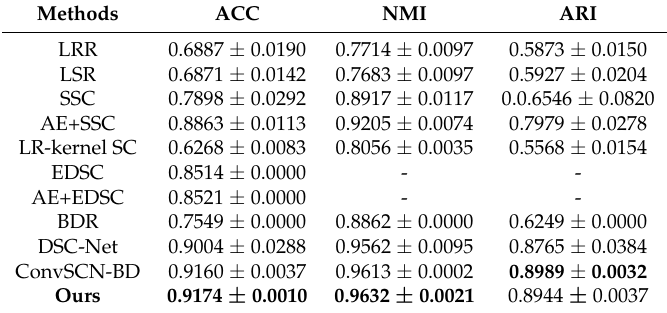
Table 5. Clustering performance of different algorithms on the COIL20 database.